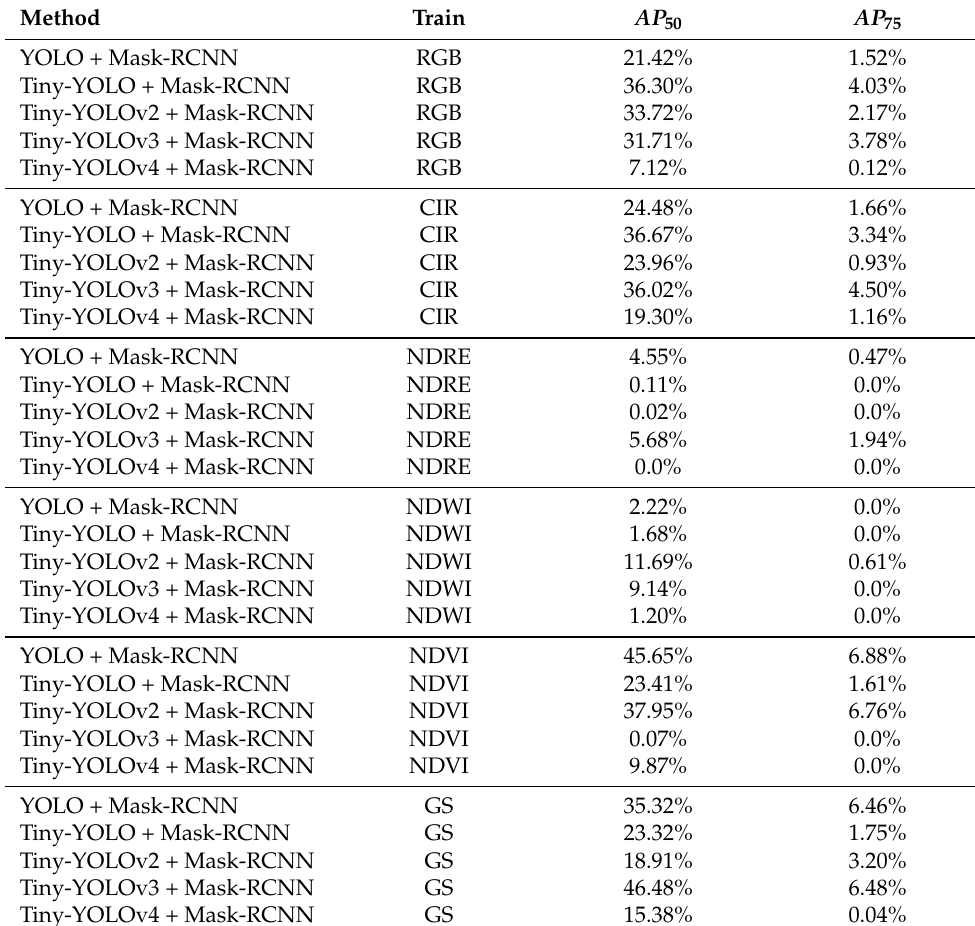
Table 4. Mask-RCNN ‘heads’ layers training for 30 epochs. Method: weights used + Mask-RCNN; Train: dataset used in training; AP 50 : average precision with an IoU of 0.5; AP 75 : average precision with an IoU